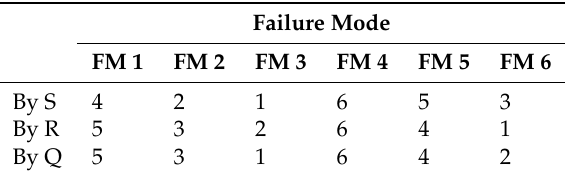
Table 9. Risk ranking of failure modes by using the extended VIKOR method in